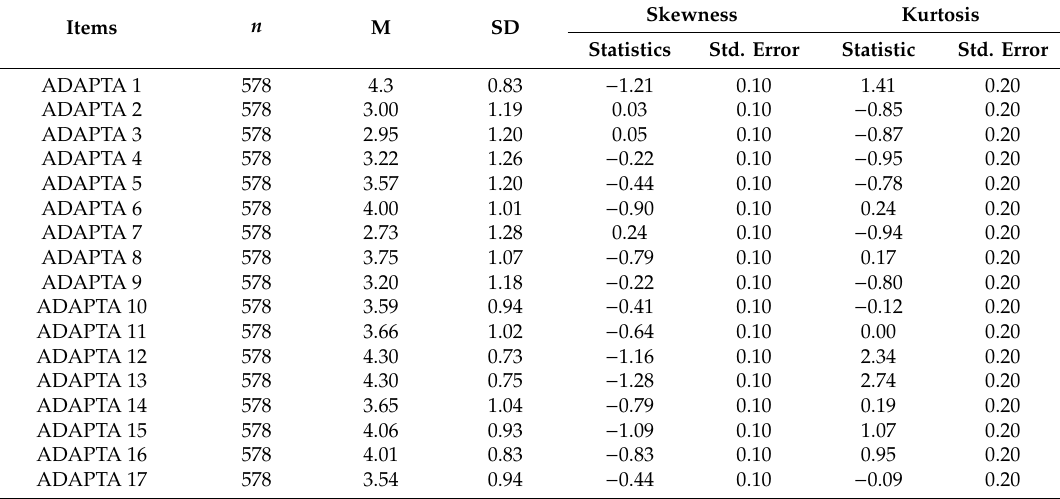
Table 1. Descriptive statistics. Calibration sample ( n = 578). SD: standard deviation, Std. Error: standard error.